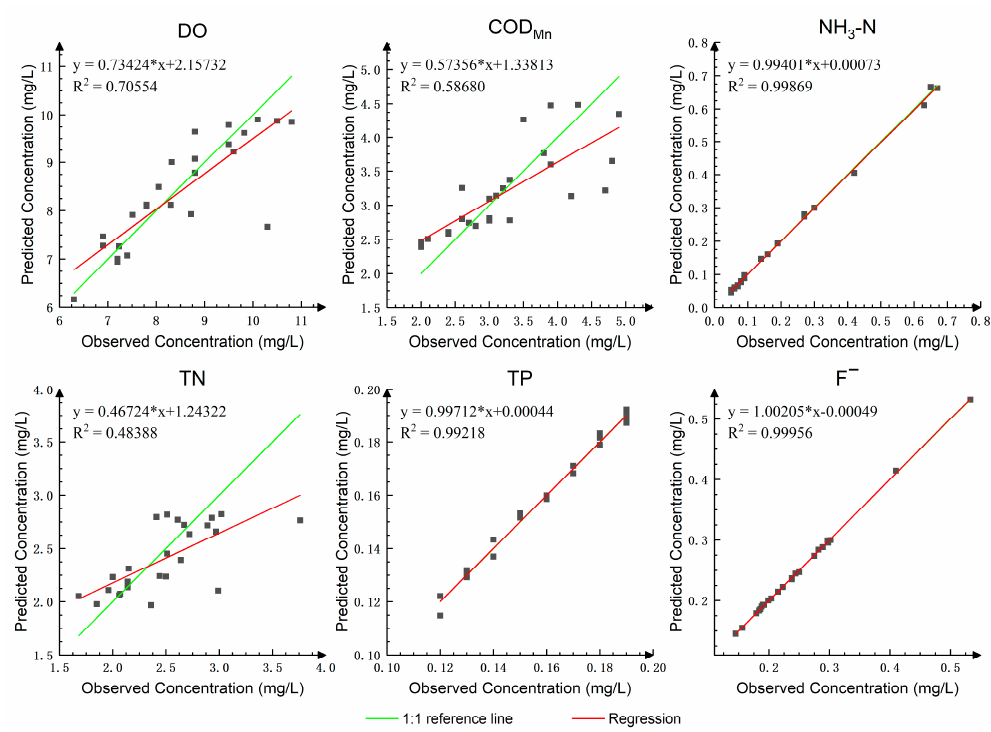
Figure 6. Midstream fitting comparison diagram of observed and predicted concentrations. Green line is the 1:1 reference line and red line is the regression line. Water 2022 , 14 , x FOR PEER REVIEW